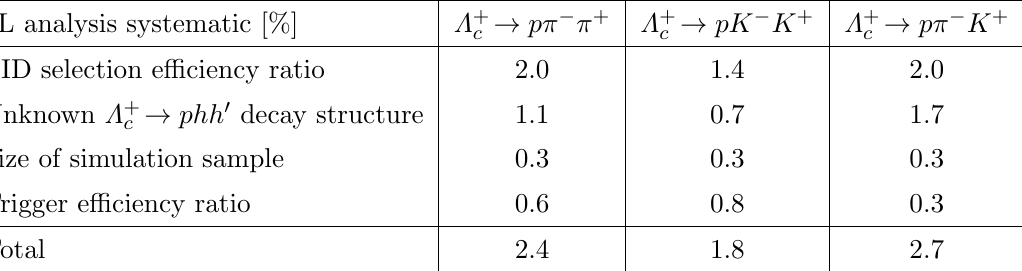
Table 3 . Relative systematic uncertainties in each ratio of branching fractions, for the SL analysis.